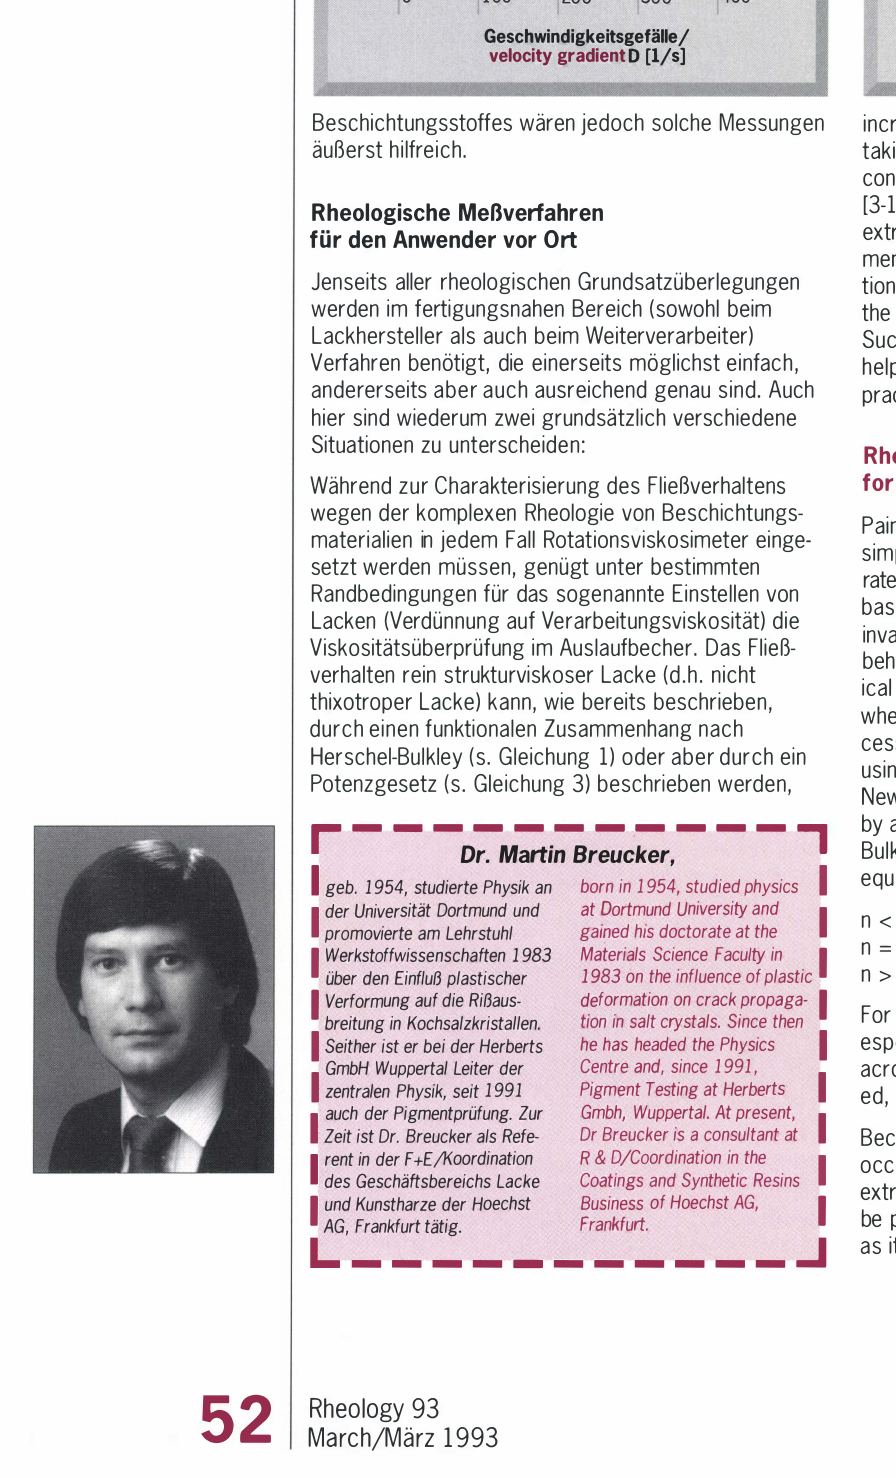
bei D ma x 1 min Fig. 3: low curve for a waterborne anti-flying stones primer at 20 o c , ramp time 4 min, hold time at D max 1 min